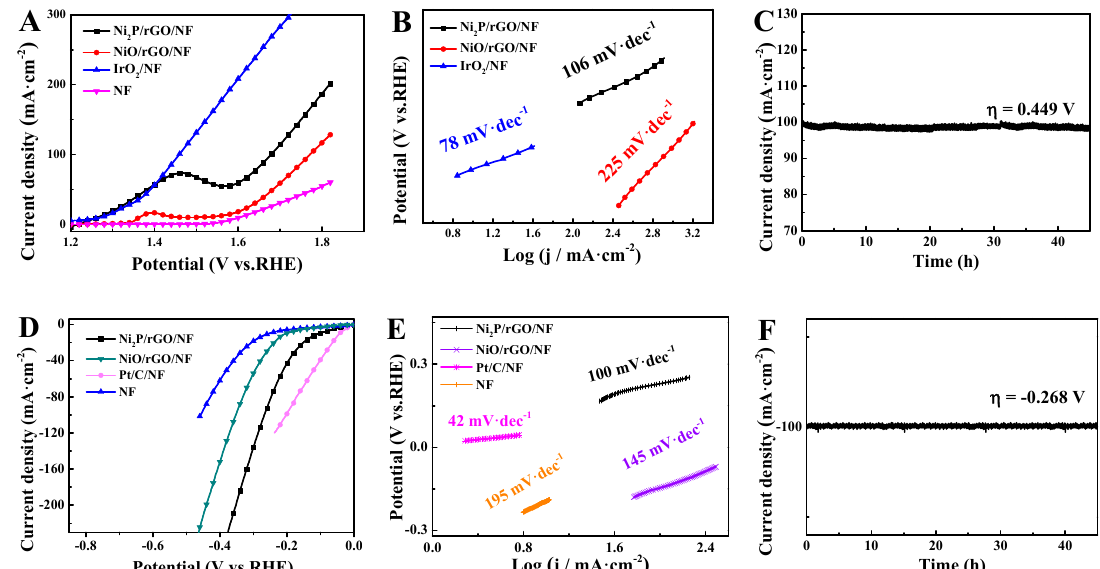
Figure 5. ( A ) LSV of Ni 2 P / rGO / NF, NiO / rGO / NF, IrO 2 / NF and NF and ( B ) Tafel slope of Ni 2 P / rGO / NF, NiO / rGO / NF, IrO 2 / NF and NF. ( C ) Multi-voltage process of Ni 2 P / rGO / NF. ( D ) LSV of Ni 2 P / rGO / NF, NiO / rGO / NF, IrO 2 / NF and NF and ( E ) Tafel slope of Ni 2 P / rGO / NF, NiO / rGO / NF, IrO 2 / NF and NF. ( F ) Chronoamperometry testing (i-t) about the Ni 2 P / rGO /